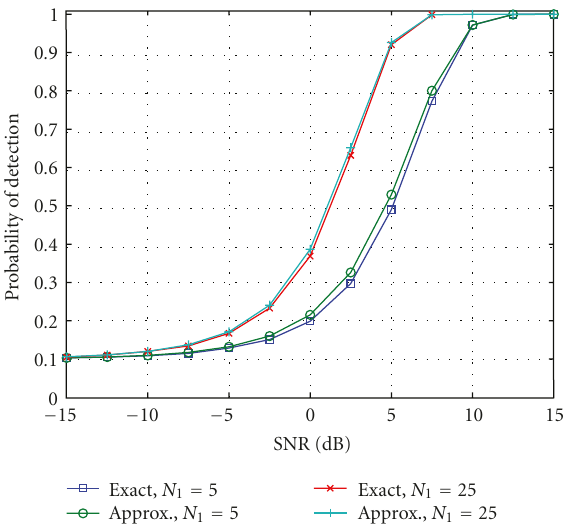
Figure 3: Probability of block detection versus SNR for N b = 10, n = 10, and ε i = 0 ∀ i / = 5.